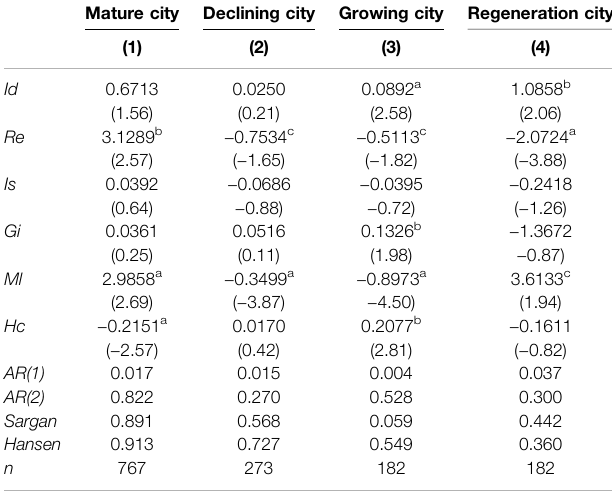
TABLE 9 | Heterogeneity test results: different life